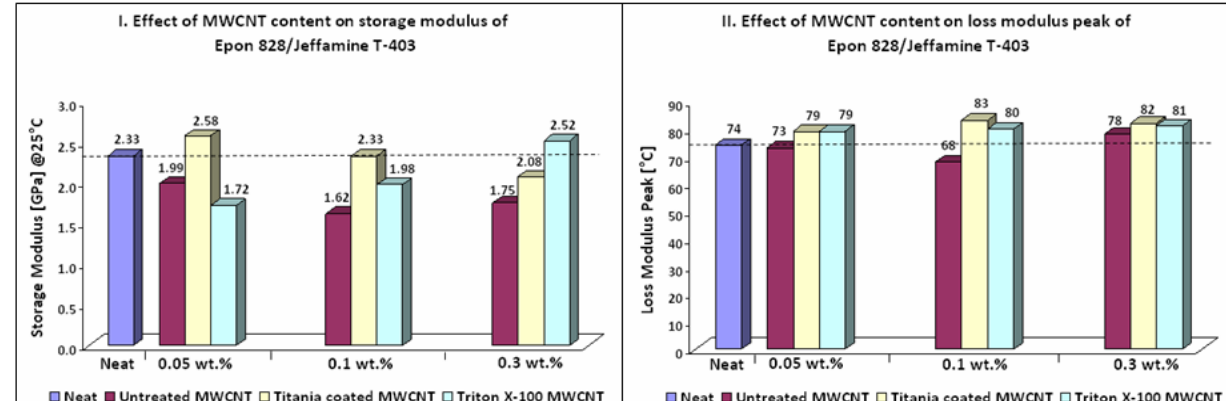
Figure 2. Effect of MWCNT content on thermo-mechanical properties of nanocomposites (Epoxy system